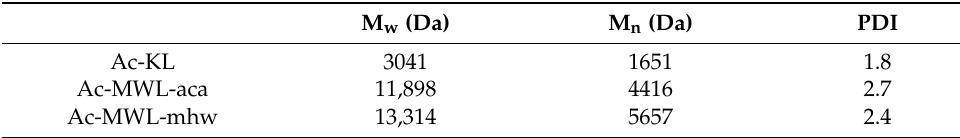
Figure 2. MW distribution of Ac-KL and Ac-MWLs. Table 4. Average MW and PDI of Ac-KL and